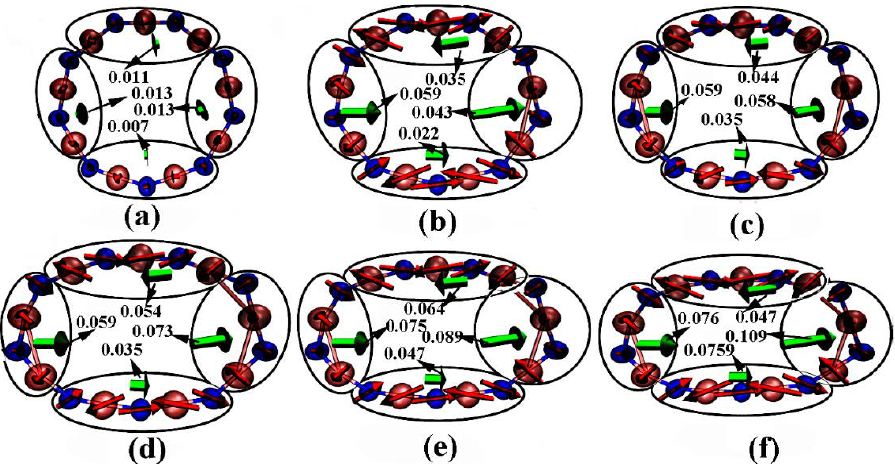
Figure 3. Diagram of B 9 N 9 molecules under varying EEF strengths. The red arrows represent the atomic force; the length of each arrow represents the magnitude of the force. In each figure, two green arrows on each side represent the resultant forces (in Hartree/Bohr) of the atoms within each circled region of the molecule. The isovalue is chosen to be 0.03. The EEFs corresponding to ( a – f ) are 0.005 a.u., 0.015 a.u., 0.02 a.u., 0.025 a.u., 0.03 a.u., and 0.0365 a.u., respectively.